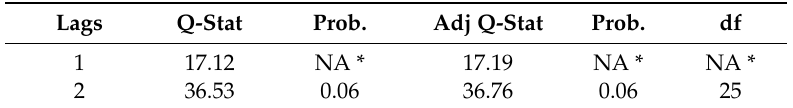
Table 3. Autocorrelation Portmanteau test.